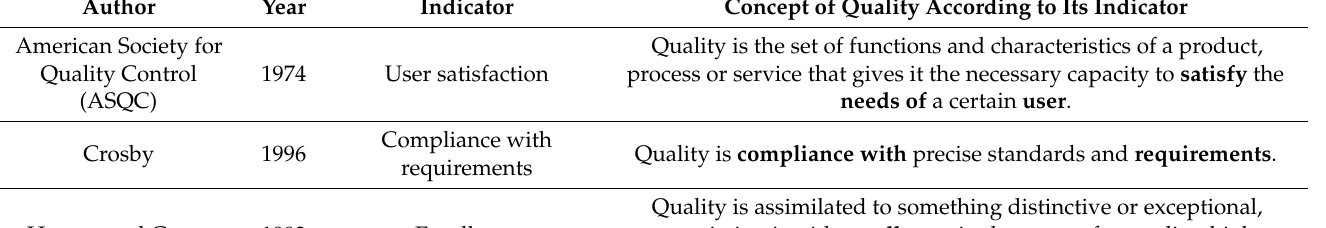
Table 1. Subjective and comparative quality indicators according to the experts, on which some selected subdimensions were based to operationalize the analyzed